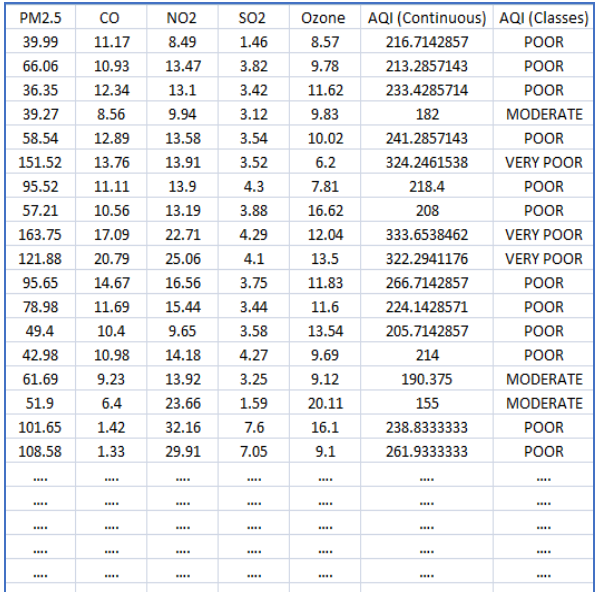
Figure 4. Subset of Air Quality Dataset